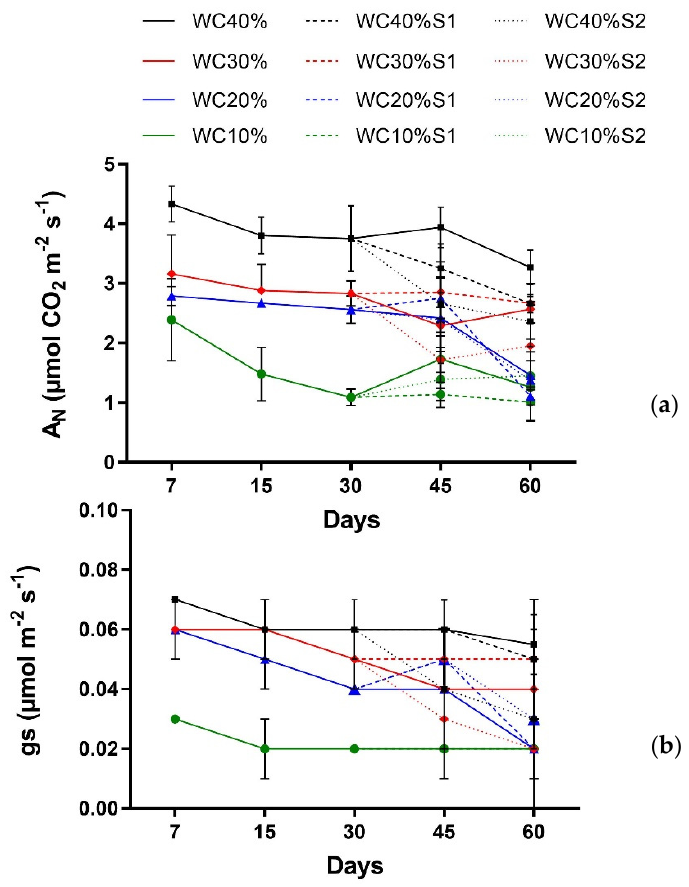
Figure 4. Trend of net photosynthesis (A N ) ( a ) and stomatal conductance (gs) ( b ) in Callistemon plants affected by drought (WC 40%: control; WC 30%: light drought stress; WC 20%: moderate drought stress; WC 10% severe drought stress) and saline aerosol treatment (S0: Distilled water, S1: 50% Synthetic seawater solution, S2: 100% Synthetic seawater solution). The plants were subjected of drought stress for four weeks; subsequently the plants were also treated with saline aerosol treatment. Data are means ± standard error ( n = 3). Three biological replicates were used for the measurements. Table 4. Summary of the main and interaction effects of days (T) and drought (D) in the first 30 days, and of days (T), drought (D), and saline aerosol (A) for the other 30 days on net photosynthesis (A N ) and stomatal conductance (gs) of potted Callistemon.